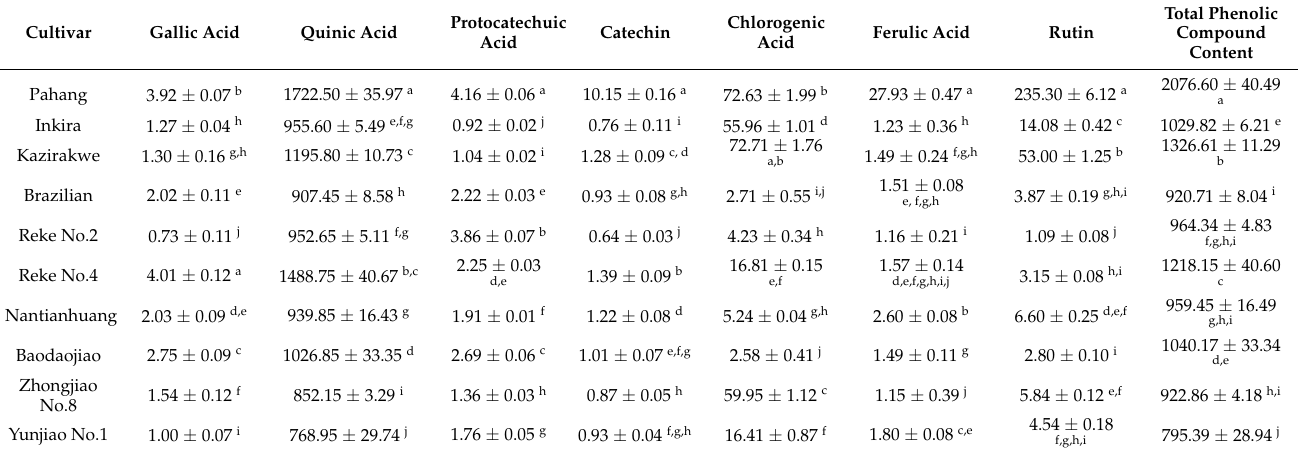
Table 6. Determination of main phenolic compounds in green fruit peel of 10 banana cultivars ( µ g/g).